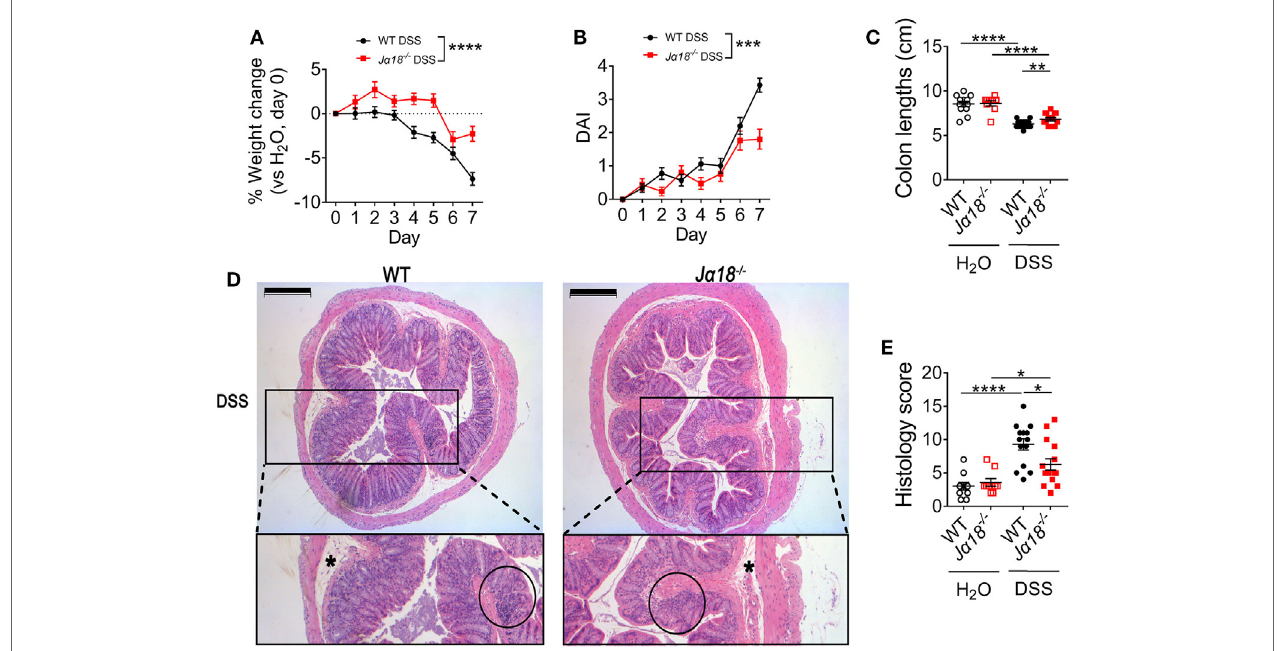
FigUre 1 | Clinical and histological pathology of 2% dextran sodium sulfate (DSS)-induced colitis in wild type (WT) and J α 18 − / − mice. (a) Changes in weight of mice treated with DSS were normalized to day 0, then to the respective H 2 O controls. (B) Disease activity index (DAI) shown for mice treated with DSS. H 2 O controls showed no visible symptoms. (c) At day 7, mice were culled, and the colon lengths measured. (D) The distal colon was collected, fixed, and embedded in paraffin. Sections of 4 µm were stained using hematoxylin and eosin. (e) Images of the colons were de-identified and randomized. Pathology was scored using four parameters and then totaled. Scale bar represents 200 µm. Asterisk (*) identifies edema. Cellular infiltration is circled. (a,B) WT DSS n = 35, J α 18 − / − DSS n = 25. (c,e) n ≥ 9. All data represent mean ± SEM. Two-way ANOVA with matched time points was used to compare the differences between two groups over time. Student’s t -test was performed. Significance is represented by * p < 0.05, ** p < 0.01, *** p < 0.001, and **** p < 0.0001. These data were obtained from at least two independent experiments.